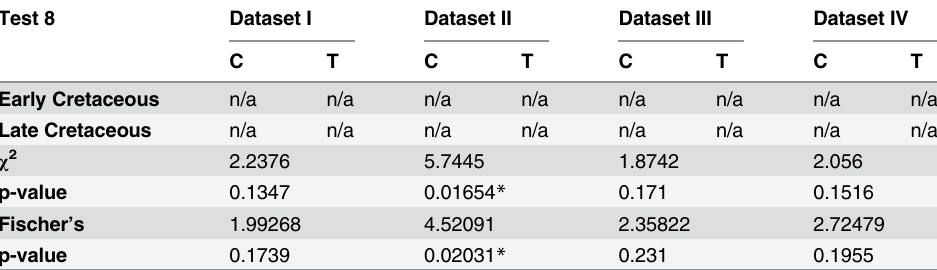
Table 9. Results of Chi-square Test 8 as presented by software